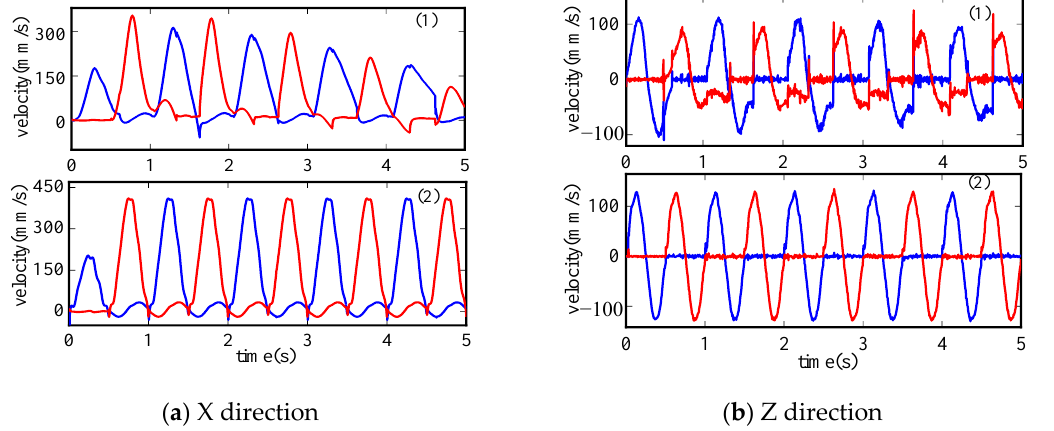
Figure 12. Comparison of foot velocity before and after optimization: ( a ) foot velocity curves in X direction cascade PID (1) and fuzzy adaptive PID (2); ( b ) foot velocity curves in Z direction cascade PID (1) and fuzzy adaptive PID (2).